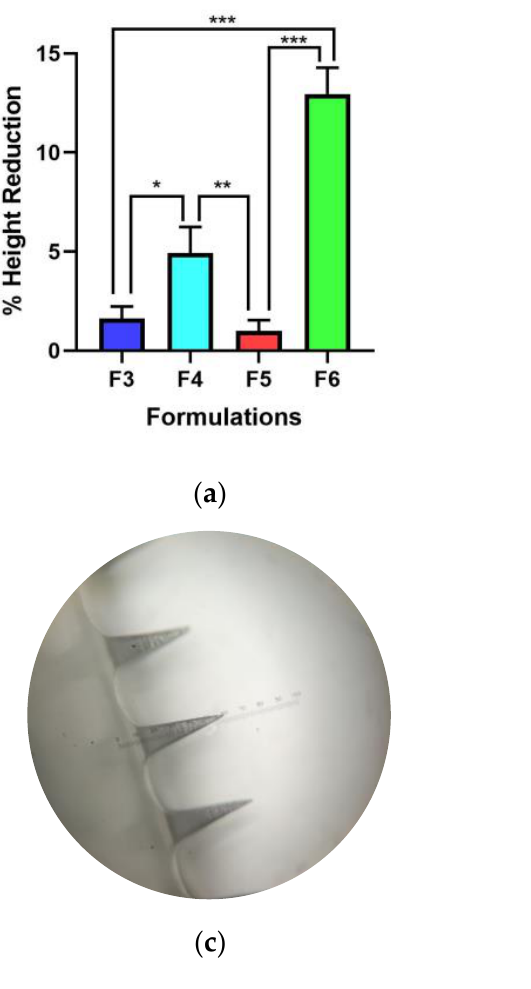
Figure 2. DMN evaluations of ( a ) mechanical strength and ( b ) loss on drying. Images of the F5 ( c ) before and ( d ) after the compression. The data presented are shown as mean + SD (n = 3; *: p < 0.05; **: p < 0.01; ***: p < 0.0005; ****: p < 0.0001).